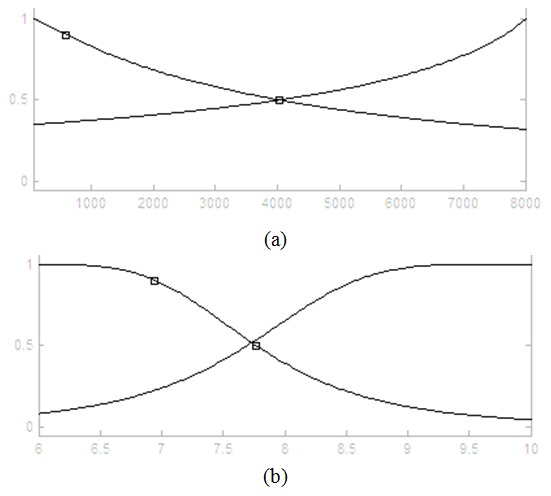
ANFIS membership functions after training procedure for (a) sound frequency and (b) wind speed fizzification.